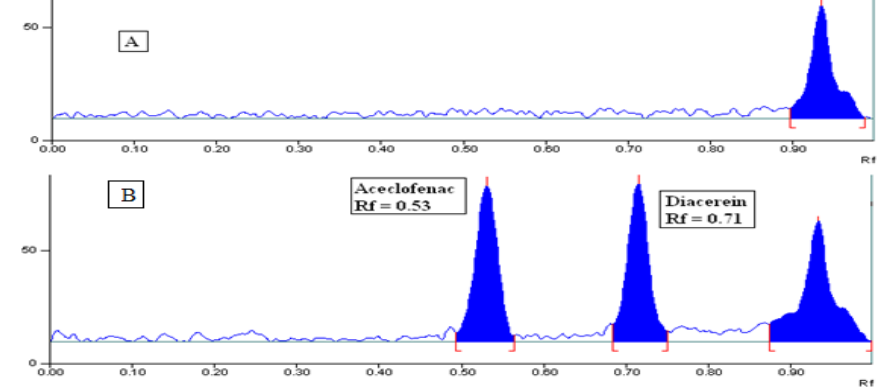
Figure 1. A- MeOH, B- Mixture (100 ng/band of both).